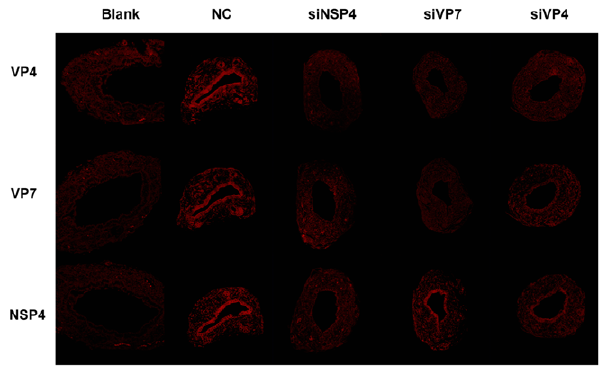
Figure 4. Immunofluorescent assay for viral protein expression in biliary epithelia of extrahepatic bile ducts on 7 dpi. Extrahepatic bile ducts infected by rotavirus expressed cytoplasmic viral proteins in the epithelial layer. siNSP4 transfection decreased the expression of NSP4, VP7 and VP4. In serial sections, NSP4 was positive but VP4 and VP7 were both negative in siVP7 transfected mice. siVP4 transfected mice had positive expression of VP7 and NSP4.